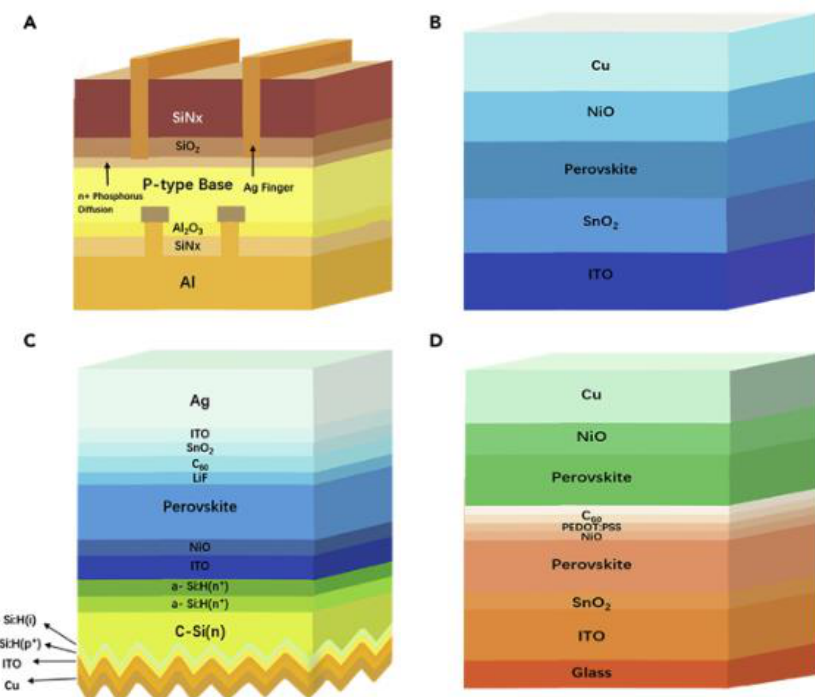
Figure 8. This is a figure data presented from ([71], p. 1561): Schematic diagram of solar cells. ( A ) is composed of traditional silicon cells, ( B ) is composed of planar perovskite cells, ( C ) is composed of silicon/perovskite tandem cells, ( D ) is composed of perovskite/perovskite tandem cells.